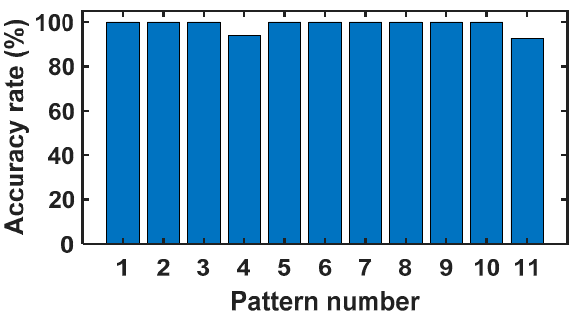
Figure 8. The accuracy rates for the 11 fault patterns.